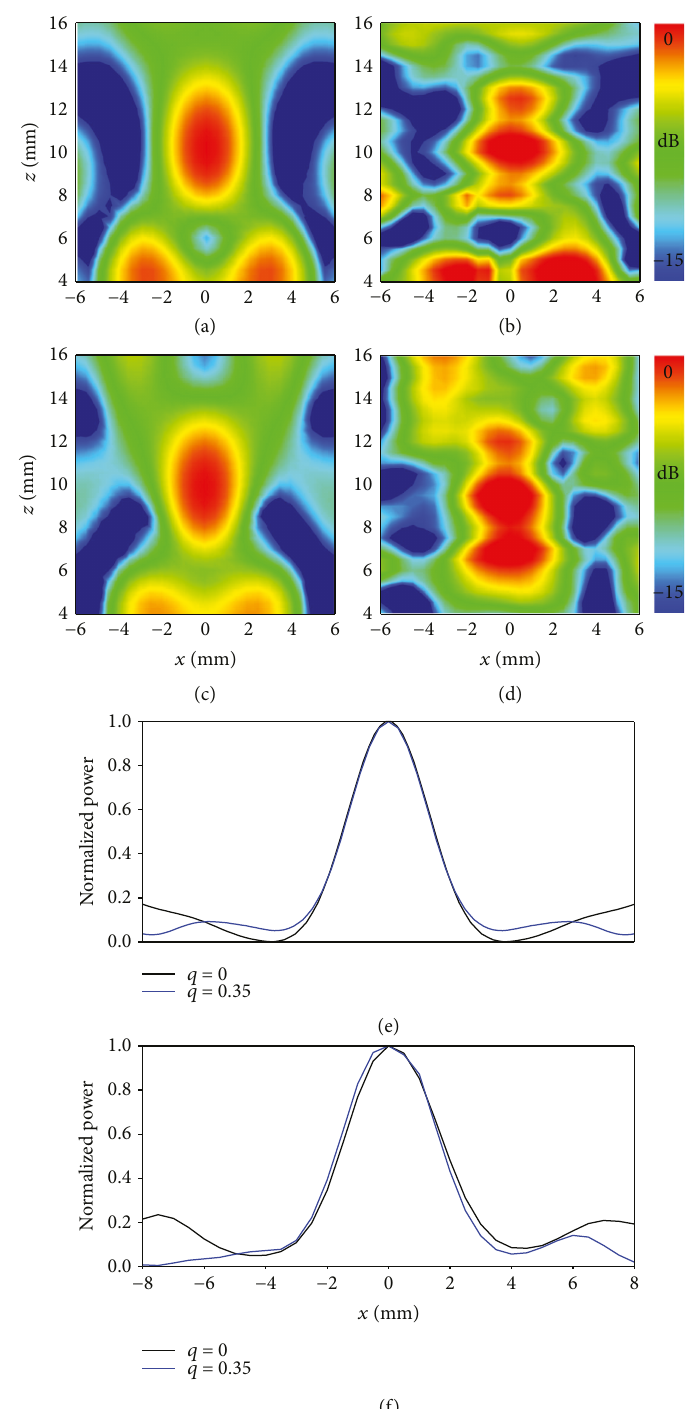
Figure 4: Focusing performance. Numerical (a, c, e) and experimental results (b, d, f) of the power distribution in the xz plane ( H - plane) for the designs with phase reversal and reference phase with a value of q = 0 (a, b) and q = 0 35 (c, d). Numerical (e) and experimental (f) values of the normalized power along the transversal x - axis at each FL for the prototypes with phase reversal and q = 0 (black) and q = 0 35